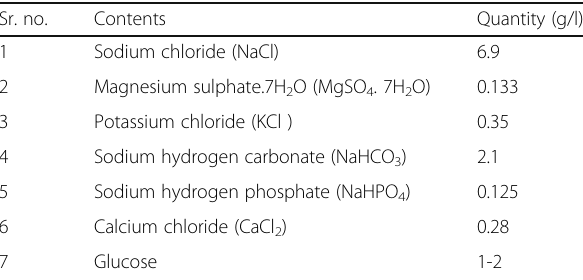
Table 1 Composition of modified KH solution Sr.